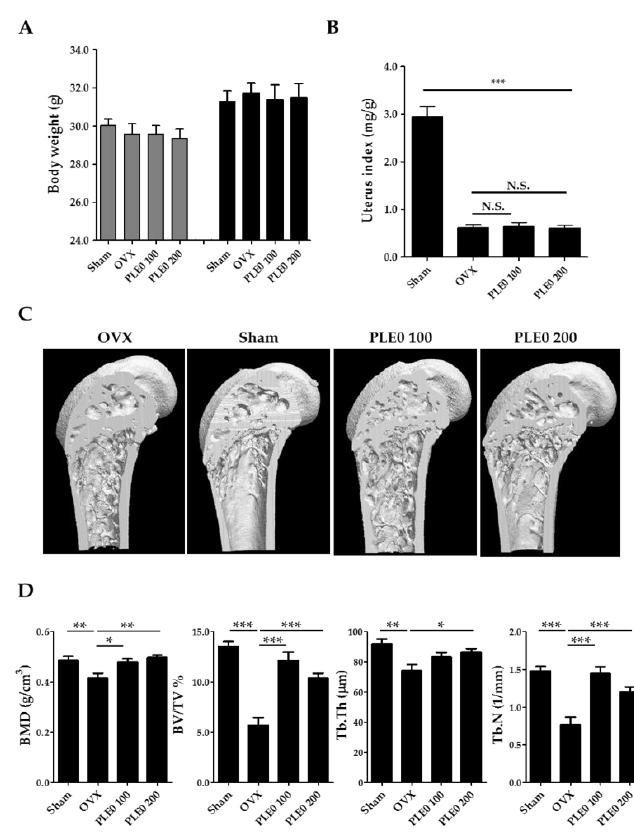
Figure 1. Effects of PLE0 on OVX-induced bone loss in mice ( n = 10). ( A ) Alteration of body weight, ( B ) relative uterus weight, ( C ) three-dimensional micro-CT images, ( D ) morphometric parameters in micro-CT analysis. The mice were randomly divided into the following four groups; sham-operated/water, OVX/water, OVX/ PLE0 low-dose treatment (100 mg/kg/day, PLE0 100), and OVX/PLE0 high-dose treatment (200 mg/kg/day, PLE0 200). BMD, Bone mineral density; BV/TV, bone volume per tissue volume; Tb. Th, trabecular thickness; Tb. N, trabecular number. All data are represented as mean ± standard error of the mean (SEM), and were analyzed with a one-way analysis of variance (ANOVA) and Dunnett’s post hoc test. *, p < 0.05 versus OVX alone; **, p < 0.01 versus OVX alone; and ***, p < 0.001 versus OVX alone. N.S., no significance.